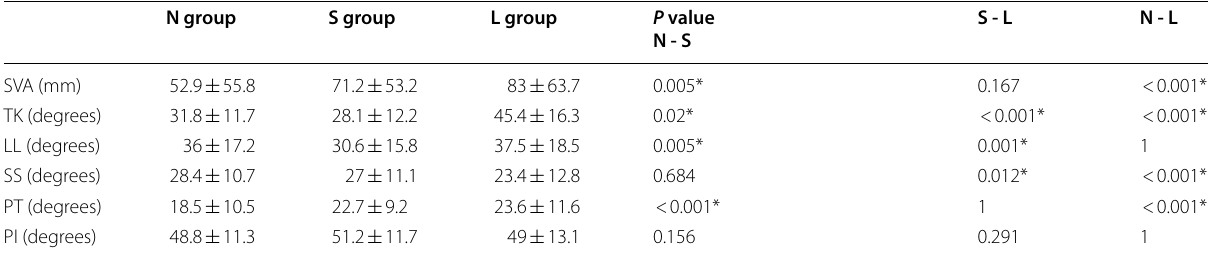
Table 2 Spinal parameters of each group at final follow-up